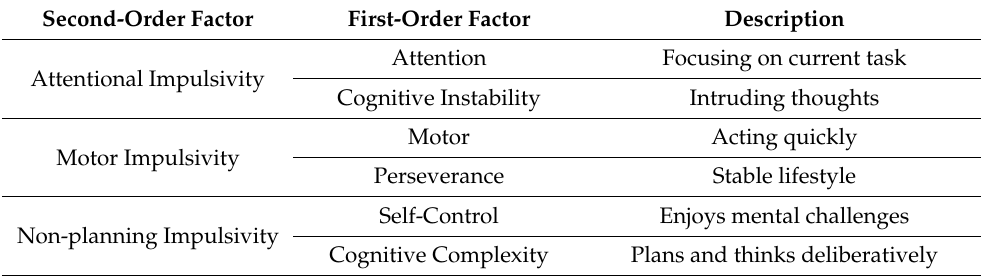
Table 1. Factor structure of the BIS-11 questionnaire according to Patton et al.